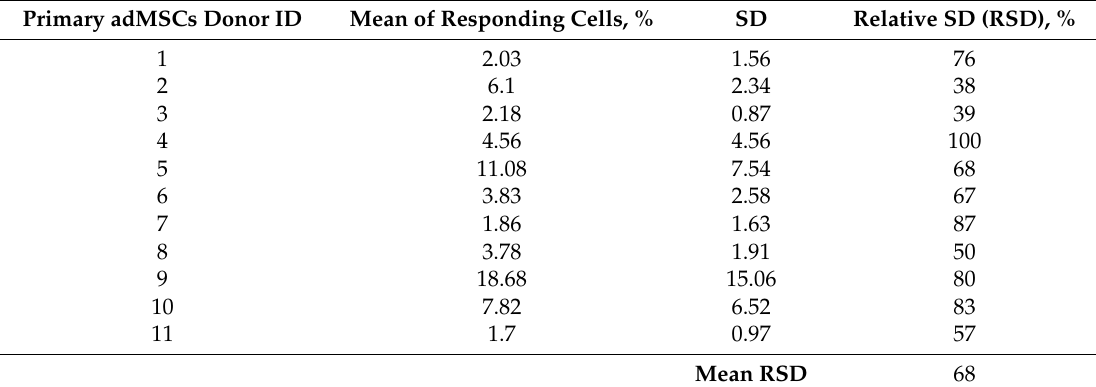
Table 1. Variation in Responsivity of Primary